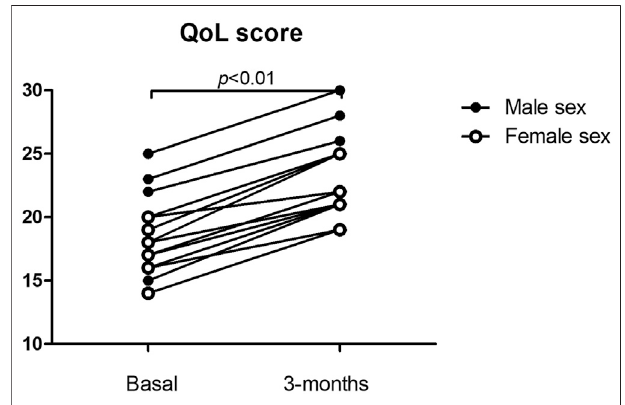
FIGURE 1 | Qql score at time 0 and after 3